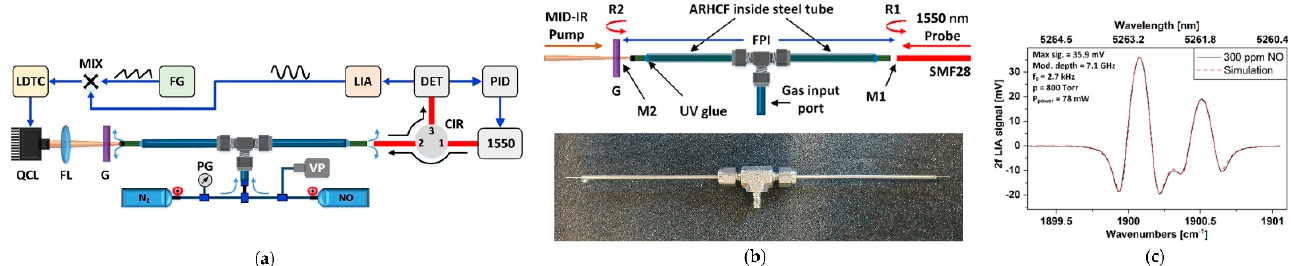
Figure 10. FPI PTS NO sensor utilizing a borosilicate ARHCF. ( a ) Schematic of the sensor setup. LDTC—laser driver, MIX—frequency mixer, FG—function generator, LIA—lock-in amplifier, DET—photodetector, PID—proportional-derivative-integral controller, CIR—circulator, G—germanium window, FL—focusing lens, QCL—quantum cascade laser, VP—vacuum pump, PG—pressure gauge. ( b ) FPI cavity (top). R1 and R2—reflections in the FPI, M1, and M2—FPI mirrors. 25 cm long ARHCF-based absorption cell (bottom) glued into a steel tube inserted into a gas delivery t-junction port. ( c ) Registered 2f signal spectrum from 300 ppmv NO in the ARHCF (black trace) and simulated (red trace). Reprinted from [52] with permission from Elsevier.